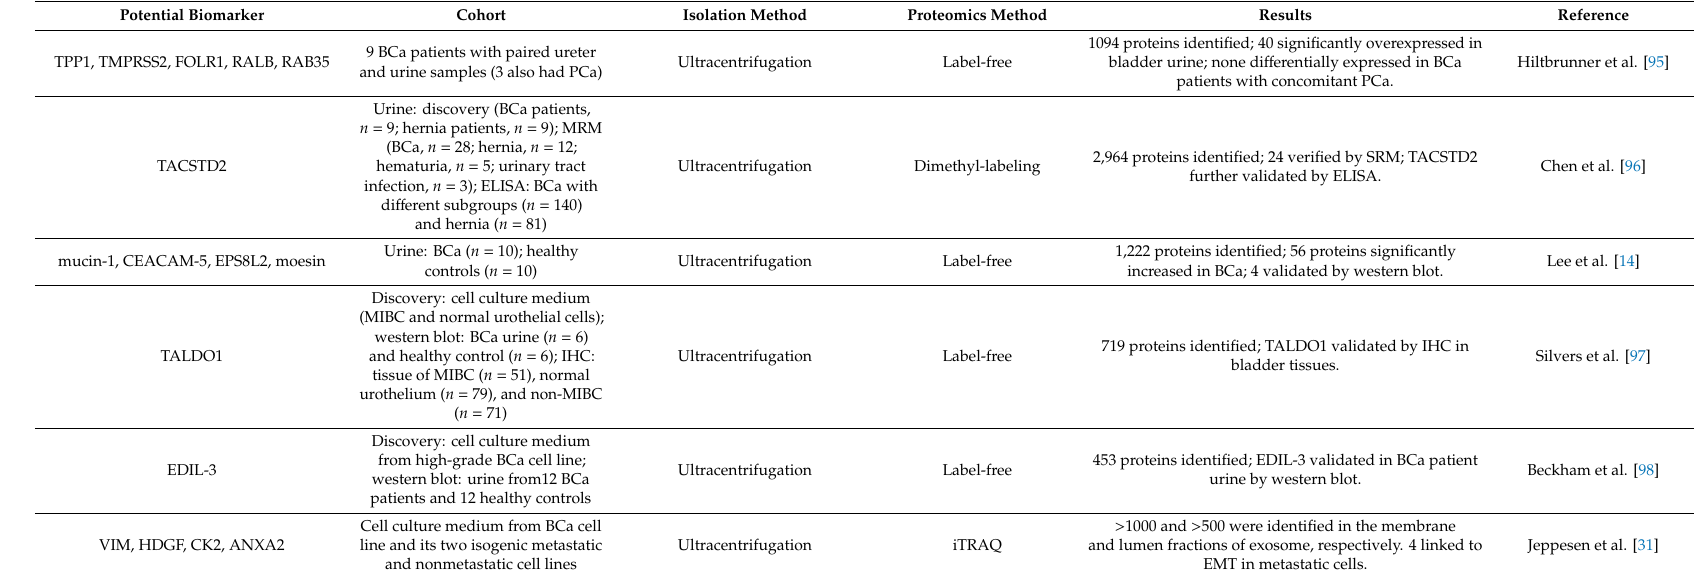
Table 3. Proteomic studies for urine exosome biomarker discovery of bladder